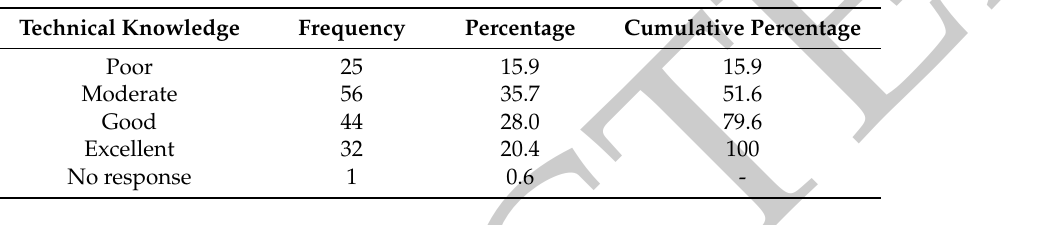
Table 4. Olive farmers’ classification in terms of technical knowledge.